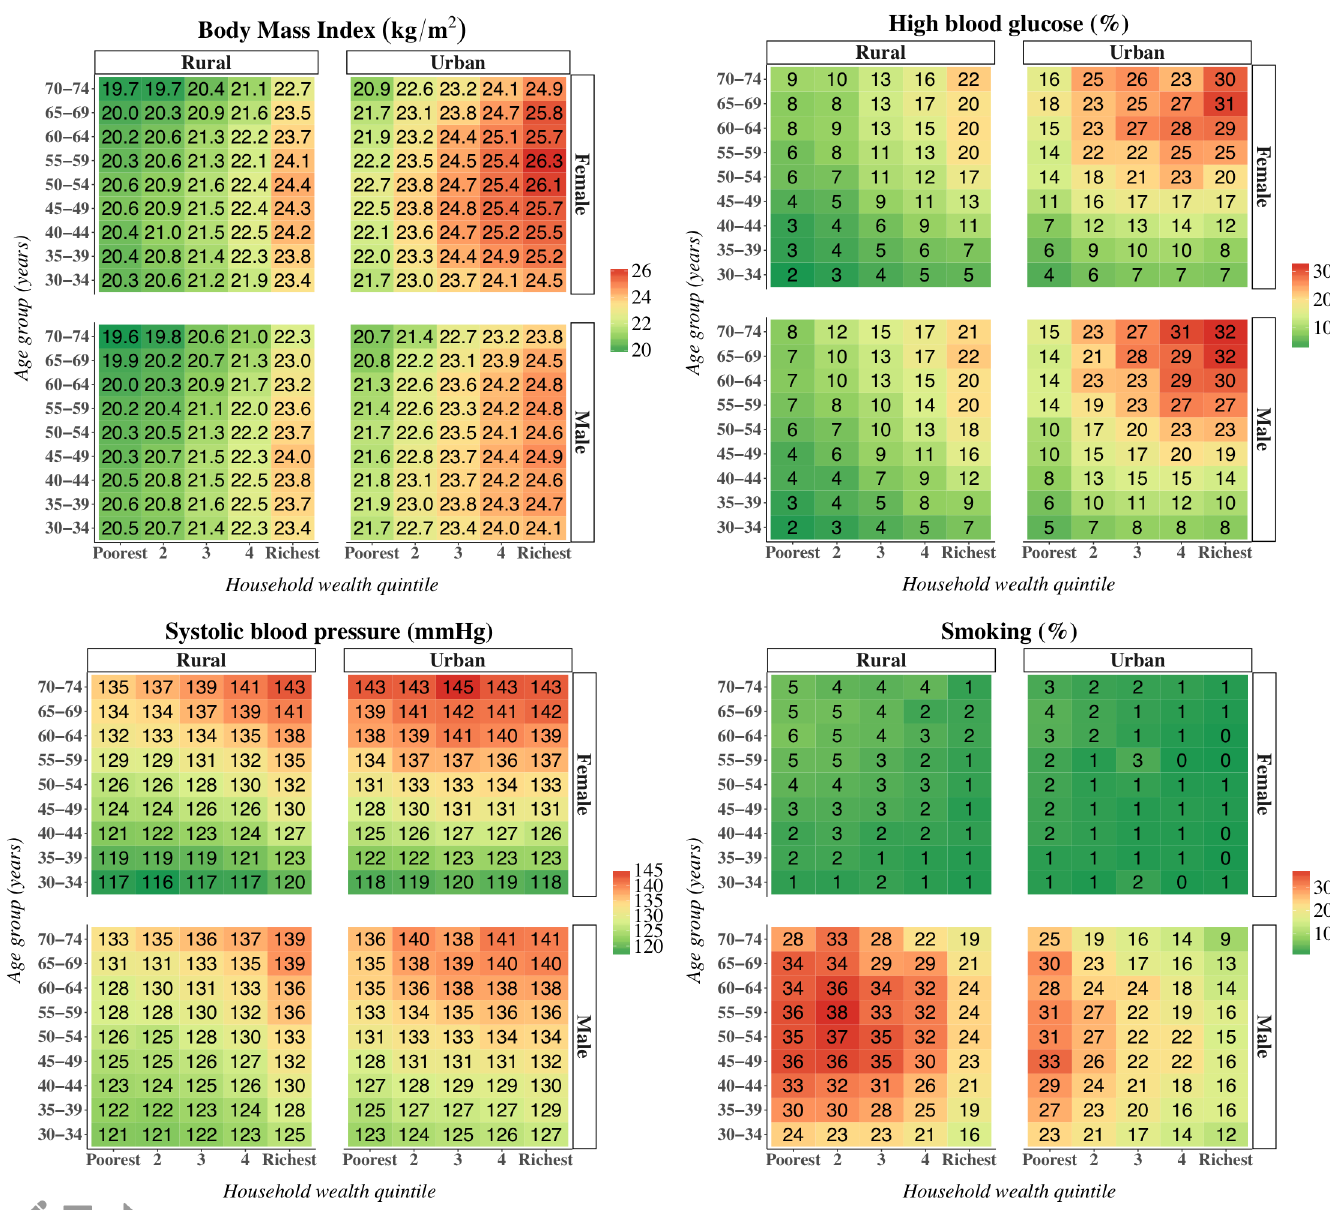
Fig 8. Mean body mass index, high blood glucose prevalence, smoking prevalence, and mean systolic blood pressure by rural versus urban residence, sex, and household wealth quintile. These are crude (not age-standardized) estimates. “Smoking” refers to smoking of any tobacco products but does not include chewing of tobacco. High blood glucose was defined as a high capillary blood glucose measurement ( (cid:21) 7.0 mmol/l if fasted and (cid:21) 11.1 mmol/l if non-fasted) or reporting to be on regular treatment for diabetes.